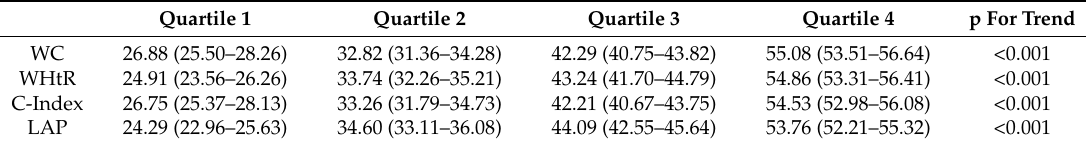
Table 3. The prevalence of hypertension by quartiles of WC, WHtR, C-Index, and LAP in both genders.